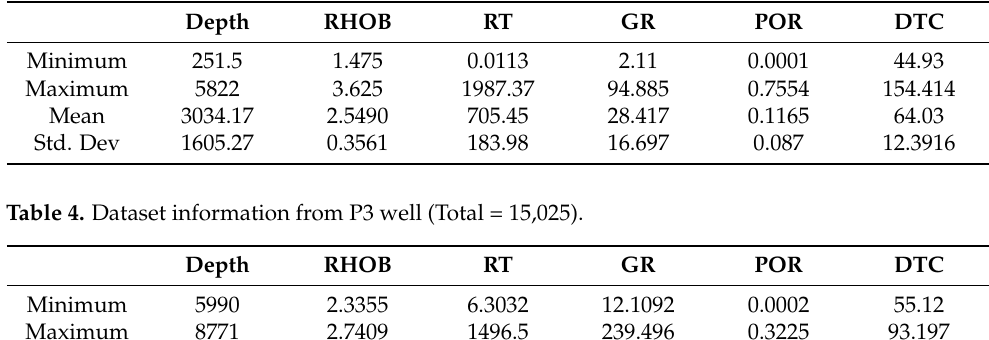
Table 3. Dataset information from P2 well (Total = 11,009).